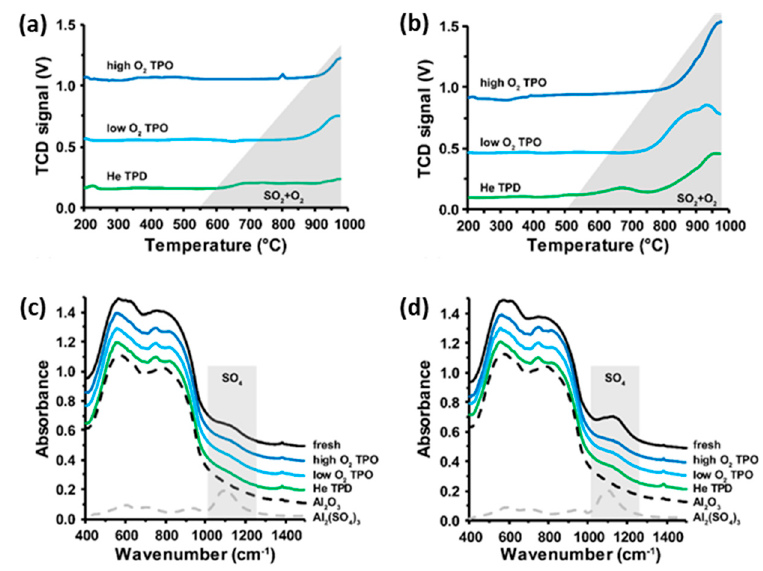
Figure 6. Thermal decomposition curves of ( a ) 0.25 AS/Al 2 O 3 and ( b ) 1.0 AS/Al 2 O 3 model catalysts together with FTIR spectra of ( c ) 0.25 AS/Al 2 O 3 and ( d ) 1.0 AS/Al 2 O 3 model catalysts before and after decomposition, accompanied by reference spectra of bulk Al 2 (SO 4 ) 3 and Al 2 O 3 .